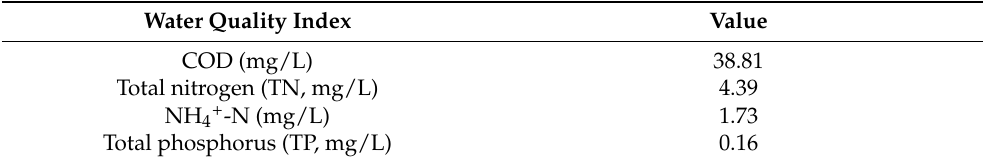
Table 1 for specific parameters of water quality. After filtering with qualitative filter paper, the river water was spiked with 10 mg/L SDZ solution for the experiment. Table 1. Water quality analysis results of the Yitong River.